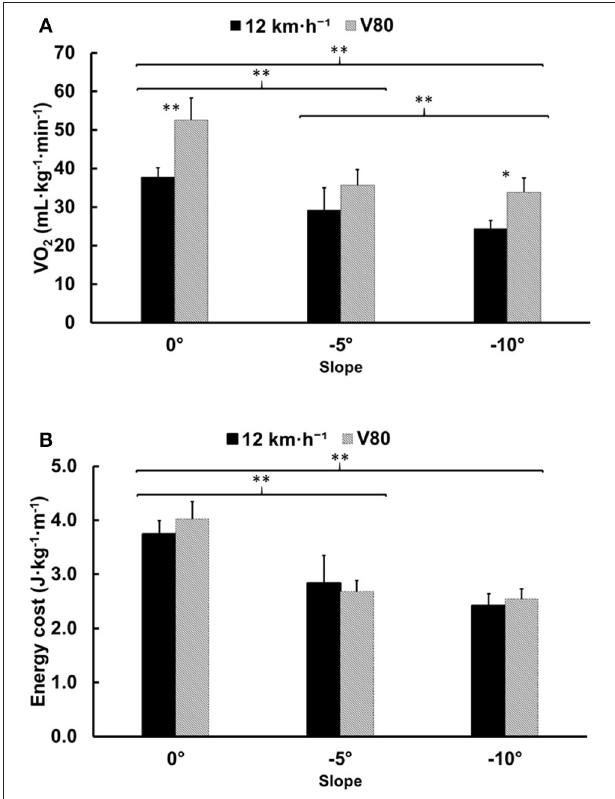
FIGURE 2 | (A) Relative oxygen uptake (mL · kg − 1 · min − 1 ) for 0 ◦ , − 5 ◦ , and − 10 ◦ slopes. (B) Energy cost of running for 0 ◦ , − 5 ◦ , and − 10 ◦ slopes expressed as joules relative to body mass per meter (J · kg − 1 · m − 1 ). Running speeds of 12 km · h − 1 and 80% of VO 2max are illustrated using black and gray bars, respectively. Brackets illustrate the differences between slopes, while * or ** above the bars indicate differences between speeds (* p < 0.05 and ** p < 0.01). The values given are mean ±